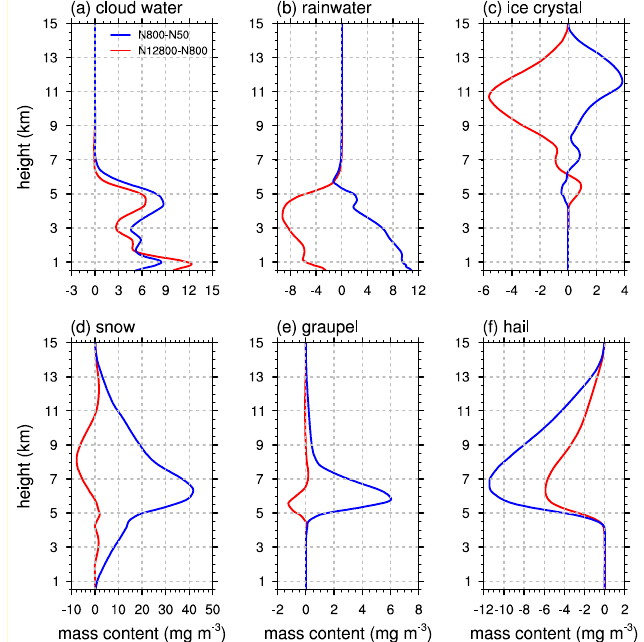
Figure 10. Vertical profiles of differences in mass contents of ( a ) cloud water, ( b ) rainwater, ( c ) ice crystal, ( d ) snow, ( e ) graupel, and ( f ) hail (blue) between the N 0 = 800 cm − 3 and N 0 = 50 cm − 3 cases and (red) between the N 0 = 12,800 cm − 3 and N 0 = 800 cm − 3 cases. Note that each panel uses its own scale. The changes in hydrometeor mass content from N 0 = 800 cm − 3 to 12,800 cm − 3 show somewhat different trends to those are seen in the changes from N 0 = 50 cm − 3 to 800 cm − 3 . While the cloud water mass content is greater in the N 0 = 12,800 cm − 3 case, the ice crystal mass content is smaller in the N 0 = 12,800 cm − 3 case except near the freezing level, which is opposite to that is seen in the comparison between the N 0 = 800 cm − 3 and N 0 = 50 cm − 3 cases, although the number concentration of ice crystals is larger in the N 0 = 12,800 cm − 3 case than in the N 0 = 800 cm − 3 case (not shown). The snow mass content is smaller in the N 0 = 12,800 cm − 3 case, particularly at z = ~6–11 km. The overall reduced mass content